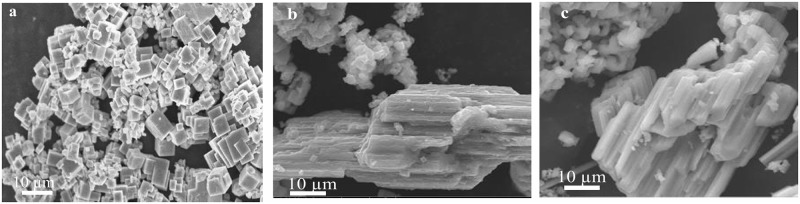
Effect of solvents on the morphology and size of NaNbO3.(a) Water. (b) Methanol. (c) Ethanol.